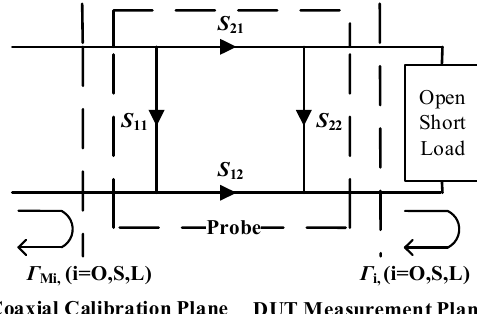
Figure 7. Signal flow chart of the OSL method.